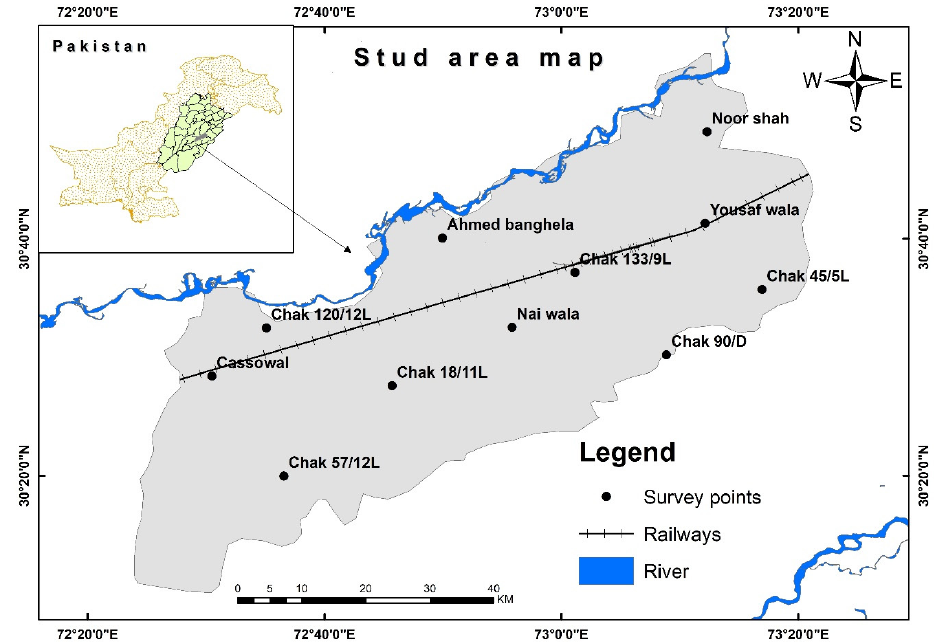
Figure 1. Study area map of the Sahiwal District.